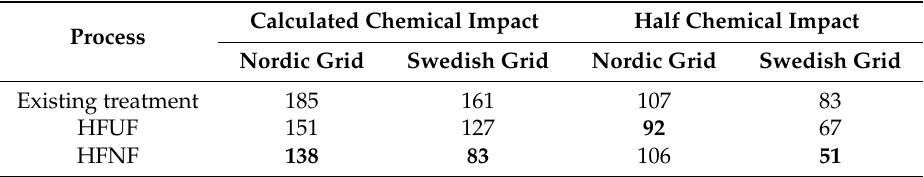
Table 4. Summary and sensitivity check for the robustness of the conclusion (g CO 2 -eq/m 3 ). Lowest number for the conditions in